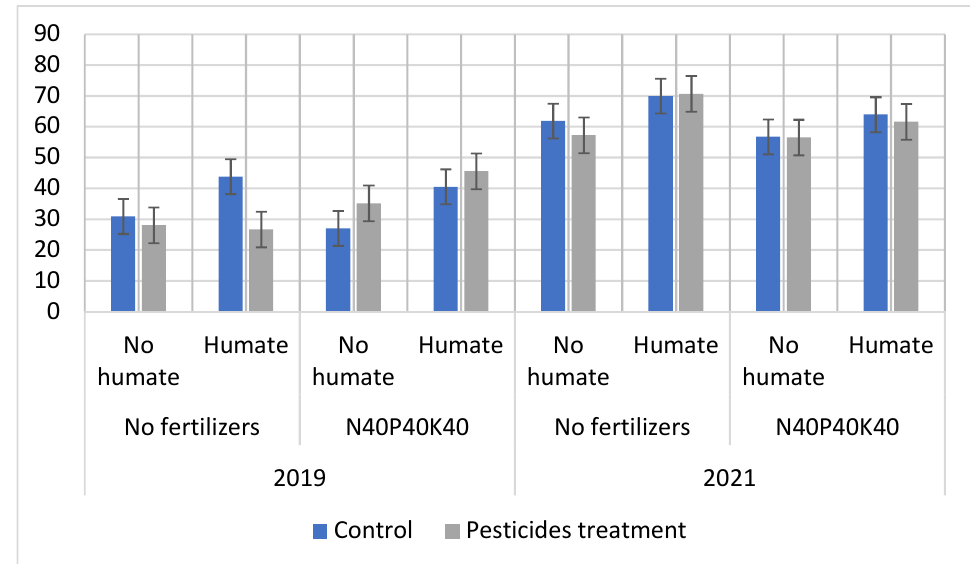
Figure 4. Influence of a humic preparation on the distribution of water-resistant soil aggregates in Calcic Chernozem under peas.